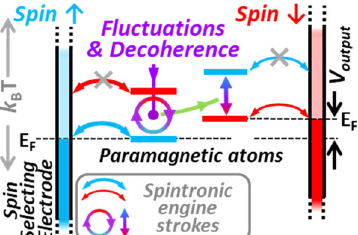
Fig. 1 A spintronic quantum information engine. Spin ↑ / ↓ is in blue/red. The spin degeneracy of the paramagnetic atom ’ s unpaired electron is dynamically lifted by transport fl uctuations (blue on left) with spin-selecting electrodes. Interactions of different strength on either side (thinner red arrow on right), along with spin selection (gray crosses) break the detailed balance of transport. Thermal fl uctuations (circular purple arrows) provide the energy to promote the electron to an excited quantum state. The quantum passivation of this excited state, and the spin measurement by the electrodes, effectively generate ergotropy, leading to a dc voltage V output . Additional quantum assets, such as entanglement between spin states (green arrow), are described in ref. 7